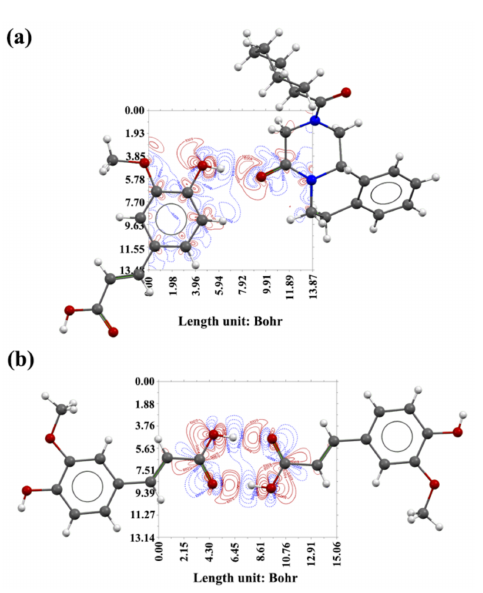
Figure 3. Hydrogen bond schemes and the corresponding contour map of the electron density